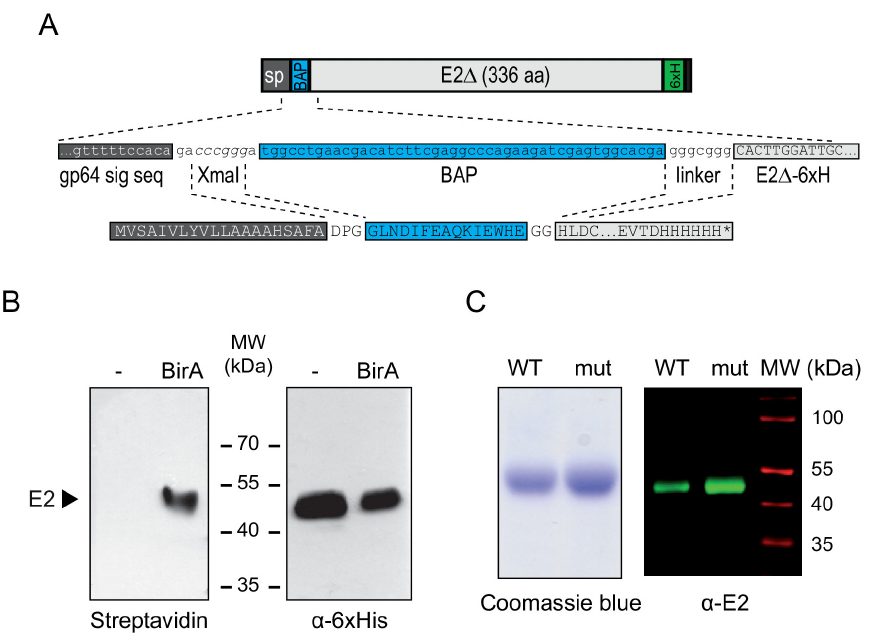
Figure 2. Design of a biotinylated version of BVDV E2. ( A ) Schematic representation of the secreted version of BVDV E2 expressed in insect cells. C-terminally truncated E2 (E2 ∆ ) was fused to bac- ulovirus GP64 signal peptide (sp) and biotin acceptor peptide (BAP) sequences at the N-terminus and to a 6xHis tag (6xH) at the C-terminus. ( B ) Site specific biotinylation of E2 in cells expressing E. coli biotin ligase BirA. The supernatants of parental or BirA expressing Sf9 cells infected with the recombinant baculovirus bearing BAP-E2 expression cassette were resolved in SDS-PAGE and sub- jected to Western blotting with HRP-conjugated streptavidin (left) or a polyclonal antibody against 6xHis (right). ( C ) Expression of wild type and mutant E2 in insect cells. Coomassie Blue staining (left) and Western blot against E2 (right) of the purified proteins resolved by SDS-PAGE. Different lines of evidence indicate that pestivirus E2 mediates receptor